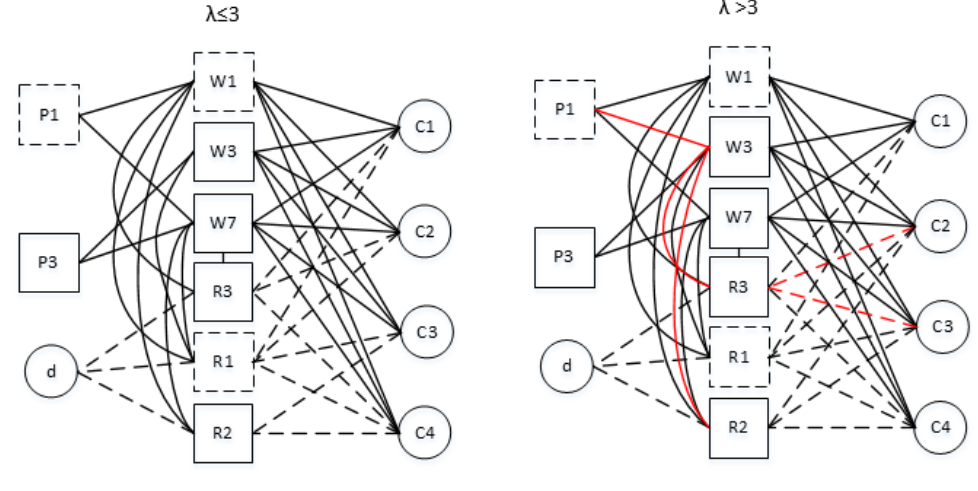
Fig. 6. Supply chain network for λ ≤3 and λ >3.